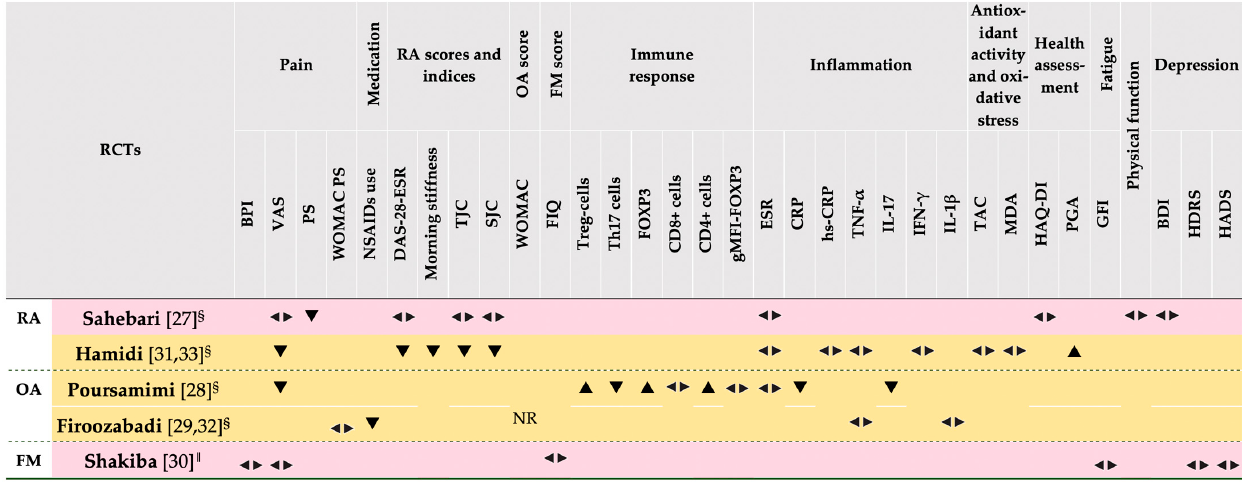
Figure 6. Qualitative synthesis without meta-analysis of the outcomes in each RCT, favoring the saffron arms post-inter- vention. All RCTs had less than 50 participants in each arm. Row background colors denote study quality according to the RoB assessment. BDI, Beck Depression Inventory [51]; BPI, Brief Pain Inventory [40]; DAS-28, disease activity score 28 [47]; ESR, erythrocyte sedimentation rate; FIQ, Fibromyalgia Impact Questionnaire [48,49]; FM, fibromyalgia; FOXP3, forkhead box protein P3; GFI, global fatigue index [44]; gMFI, geometric mean fluorescence intensity; HADS, Hospital Anxiety and Depression Scale [46]; HAQ-DI, health assessment questionnaire-disability index [42]; HDRS, Hamilton Depression Rating